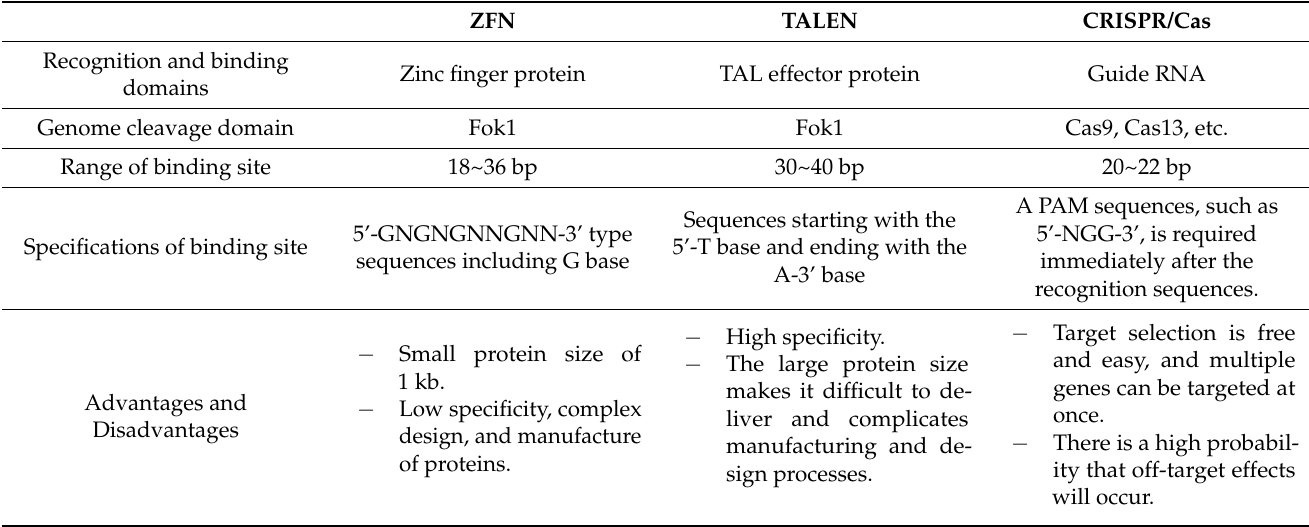
Table 1. Comparison between genome editing